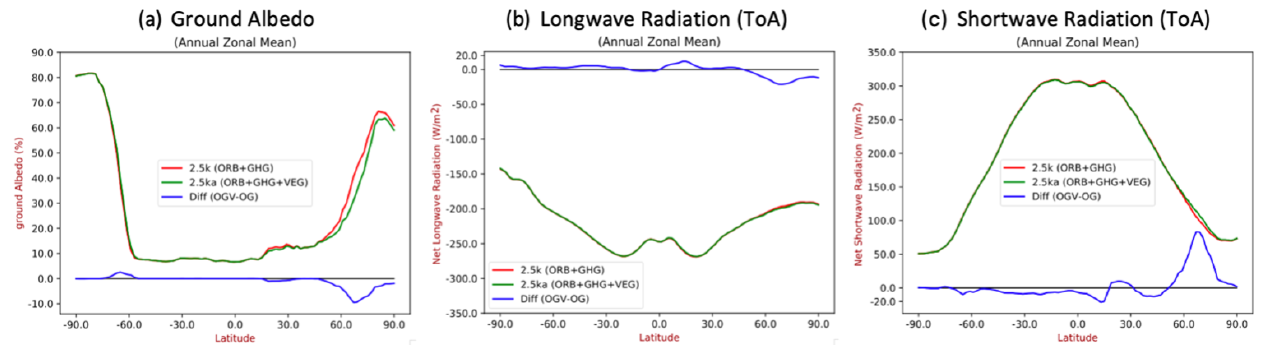
Figure 3. Annual zonal mean of ground albedo (a) , longwave and shortwave radiation at the top of the atmosphere (TOA; b and c ) for 2.5ka climates with ORB + GHG and ORB + GHG + VEG (red and green lines), respectively. The blue line shows the difference between them. The blue line in panel (b) and (c) is exaggerated 10-fold ( × 10) to show the difference more clearly on the same vertical